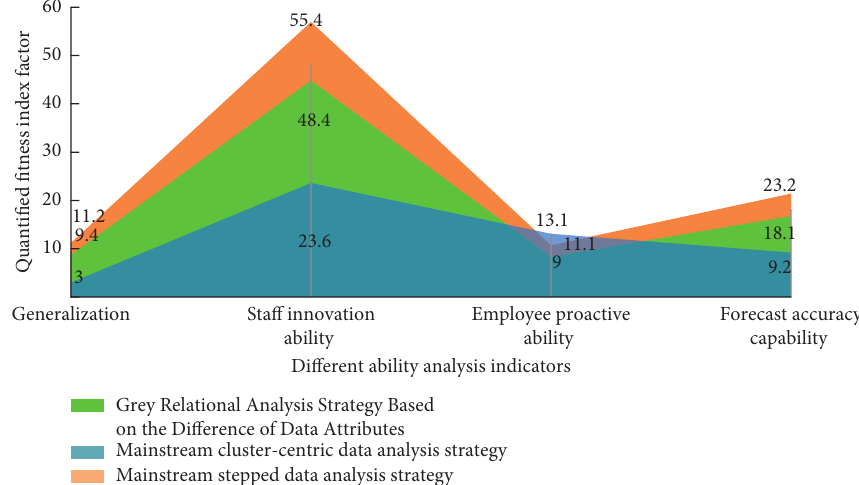
Figure 9: Fitting analysis of data involving performance direction of a domestic listed company in the mid-12months of 2019 by 3 different methods.